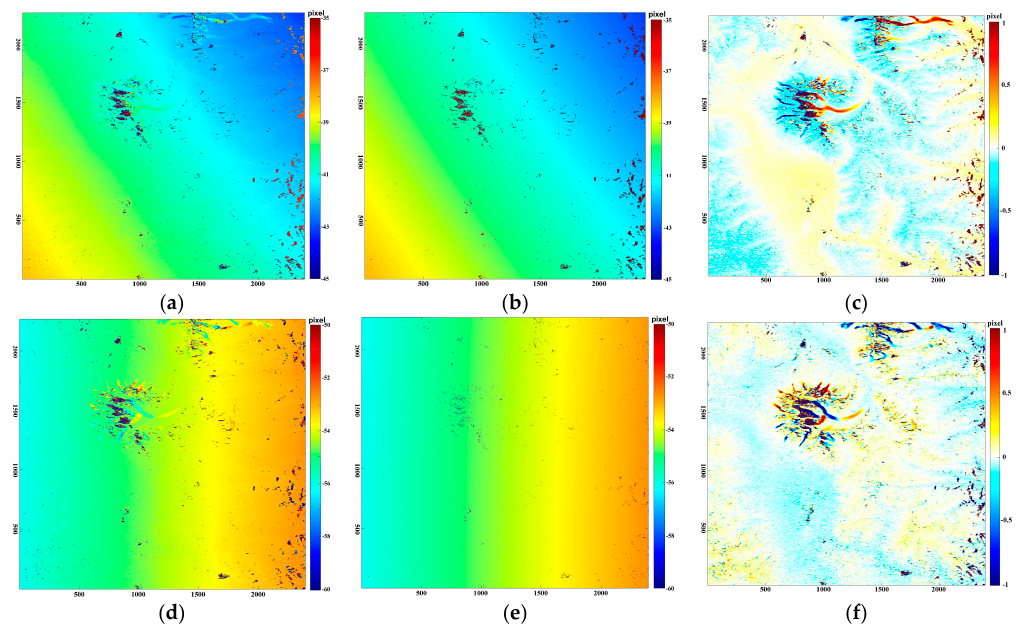
Figure 3. The RANSAC-based global deformation estimation and compensation: ( a , d ) are the initial offset distributions in the range and azimuth directions; ( b , e ) are the global deformations corresponding to the orbit and sensor attitude in both directions; and ( c , f ) are the offset fields with the global deformation removed.